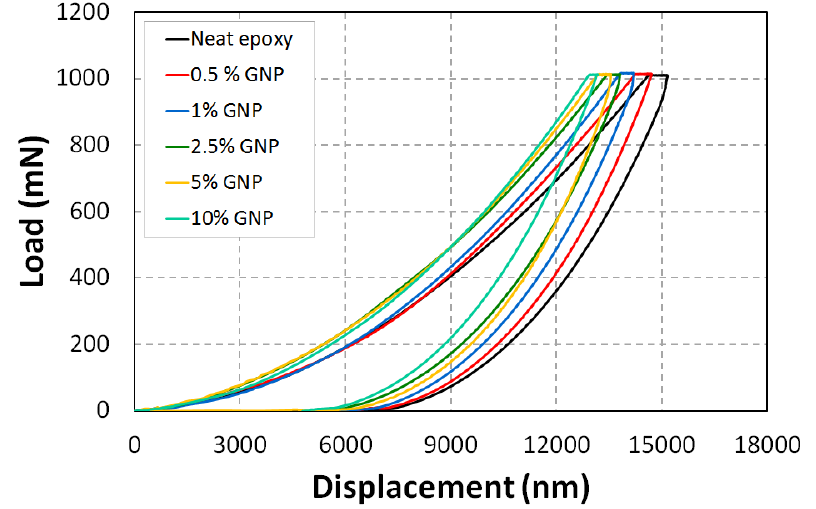
Figure 12. Graphene effect on local mechanical behavior, indentation tests.